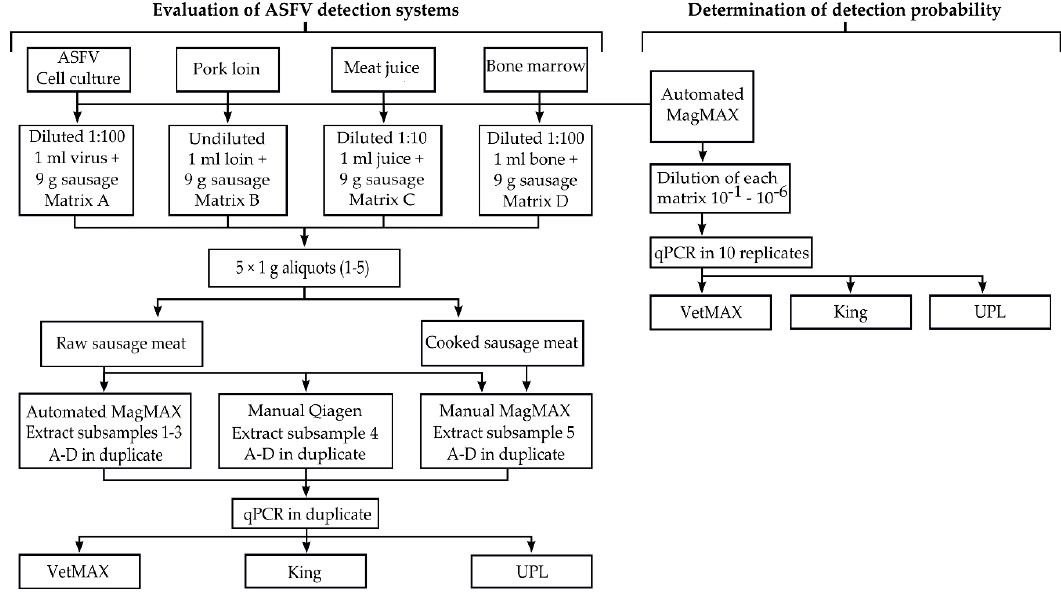
Figure 1. Flowchart of the evaluation of African swine fever virus (ASFV) detection systems.